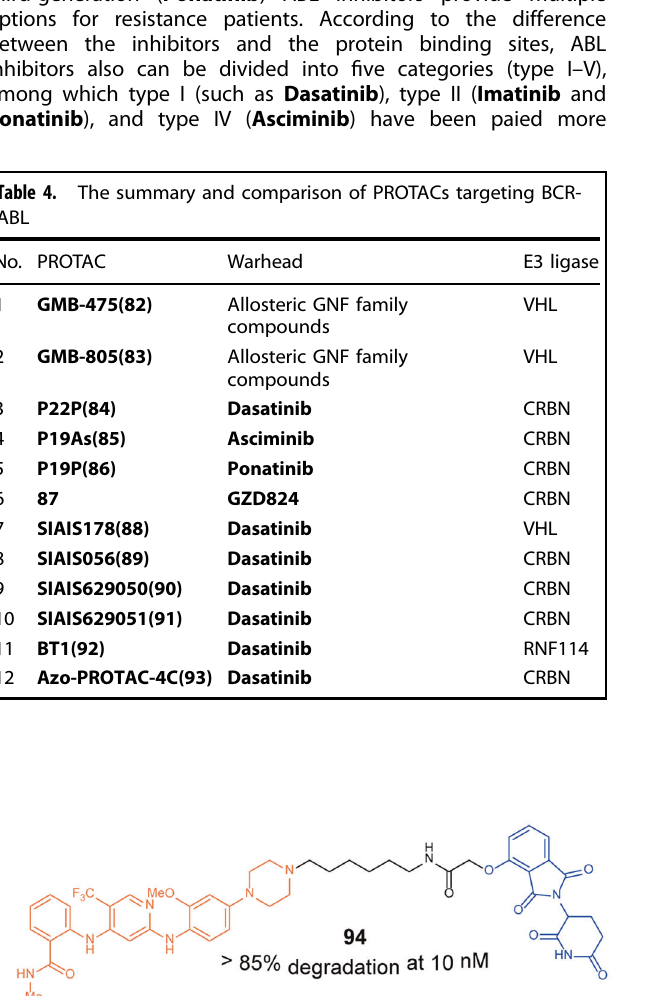
Signal Transduction and Targeted Therapy (2022)